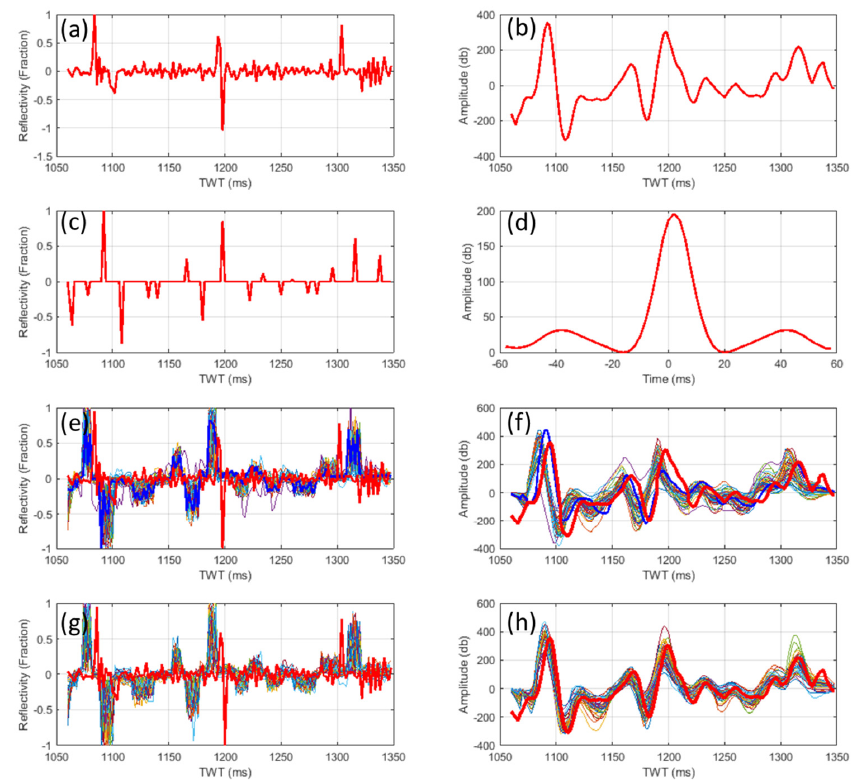
Figure 7. Stochastic process of EEI porosity enhancement. ( a ) porosity log reflectivity; ( b ) EEI porosity signature at Well-1 location; ( c ) initial prior EEI reflectivity extracted from EEI signature; ( d ) applied wavelet statistically extracted from EEI signature; ( e ) 50 prior perturbed EEI reflectivity models (thin colorful curves) overlaid by its associated posterior (thick blue curve) and log porosity reflectivity (thick red curve); ( f ) 50 prior EEI signature models, associated with the 50 EEI prior reflectivity ( e ), overlaid by its associated posterior EEI signature (thick blue curve) and the observed EEI signature (thick red curve); ( g ) 50 EEI reflectivity posterior models collected from 50 independent Bayesian-MCMC simulations; ( h ) 50 EEI signature posterior models associated with the 50 EEI reflectivity prior models ( f